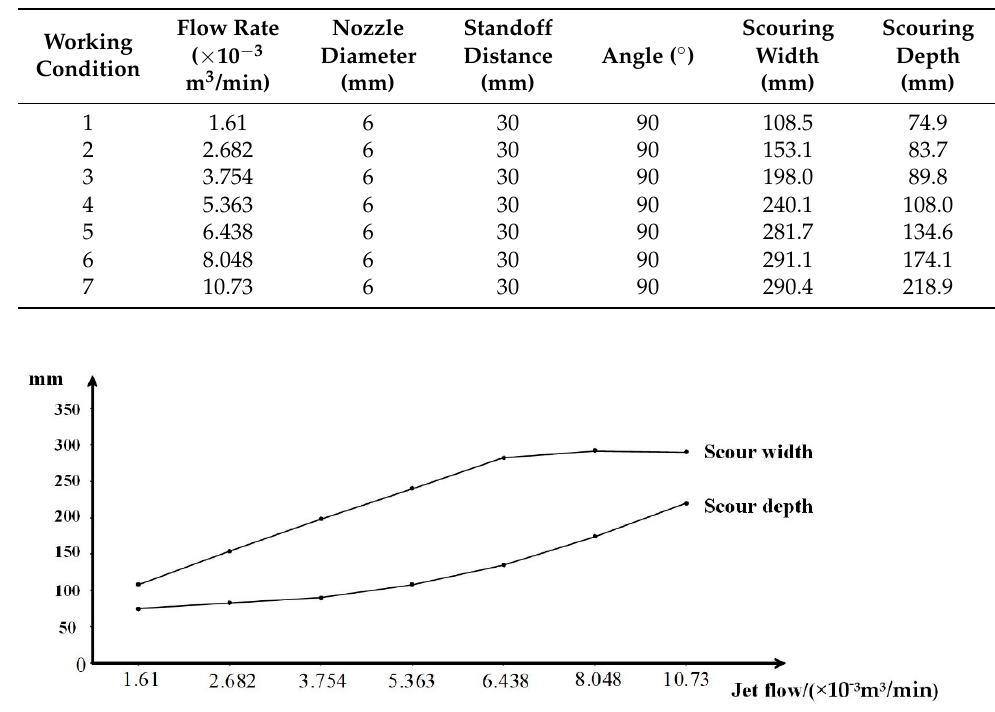
Table 7. Scouring effect at different jet flow rate.